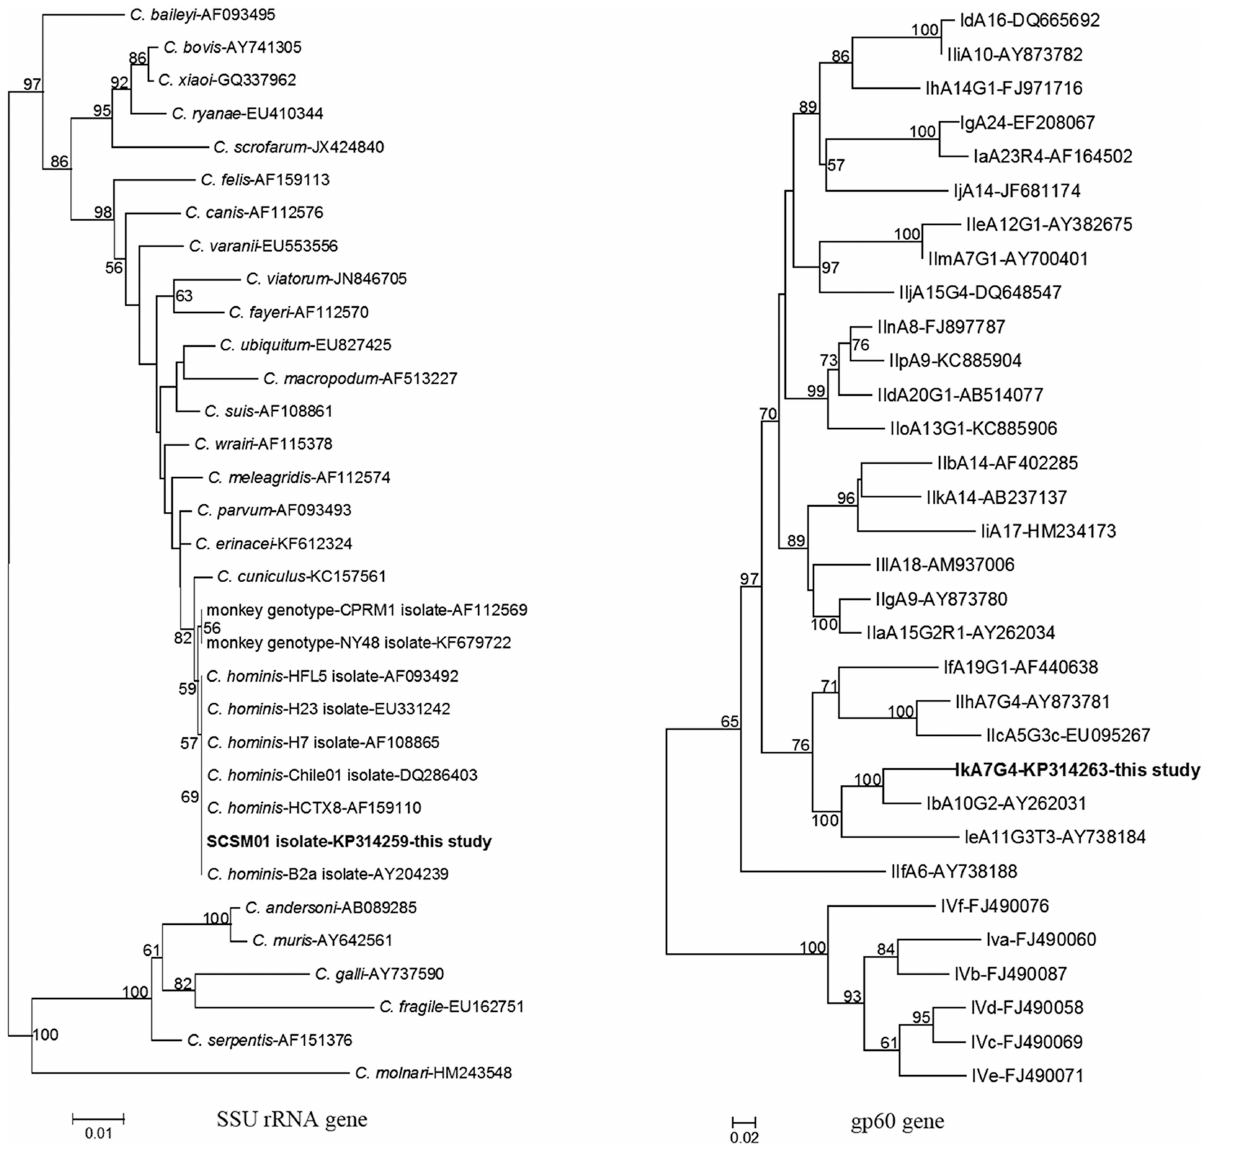
Fig 1. Phylogenetic relationship of the SSU rRNA and gp60 genes sequences of Cryptosporidium squirrel monkey isolate in this study to other known Cryptosporidium species/genotype and multiple subtype families in C . hominis , respectively, as inferred by a neighbor-joining analysis based on evolutionary distances calculated using the Kimura two-parameter model. The tree was rooted with partial subtypes of C . fayer for the gp60 gene. Bootstrap values were obtained using 1,000 pseudo-replicates.